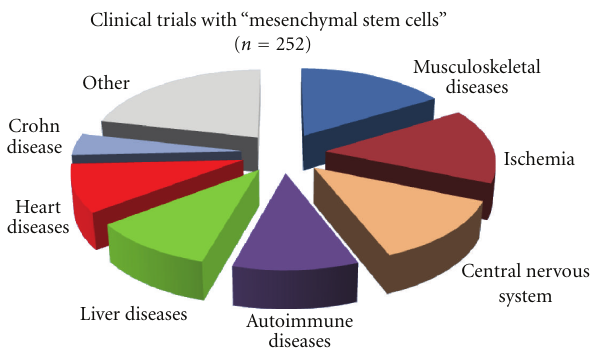
Figure 1: MSCs in clinical trials. 252 trials have been registered at http://www.clinicaltrials.gov/ (including 46 in North America, 61 in Europe, and 92 in East Asia, assessed on 11/20/2012). MSCs are tested for a broad range of diseases, and selected categories are